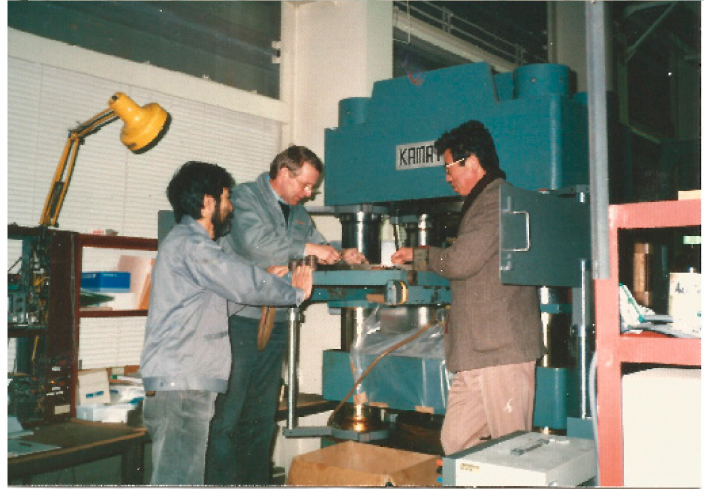
Figure 21. Vollstaedt in Tsukuba, Japan (central, left Kanda, right